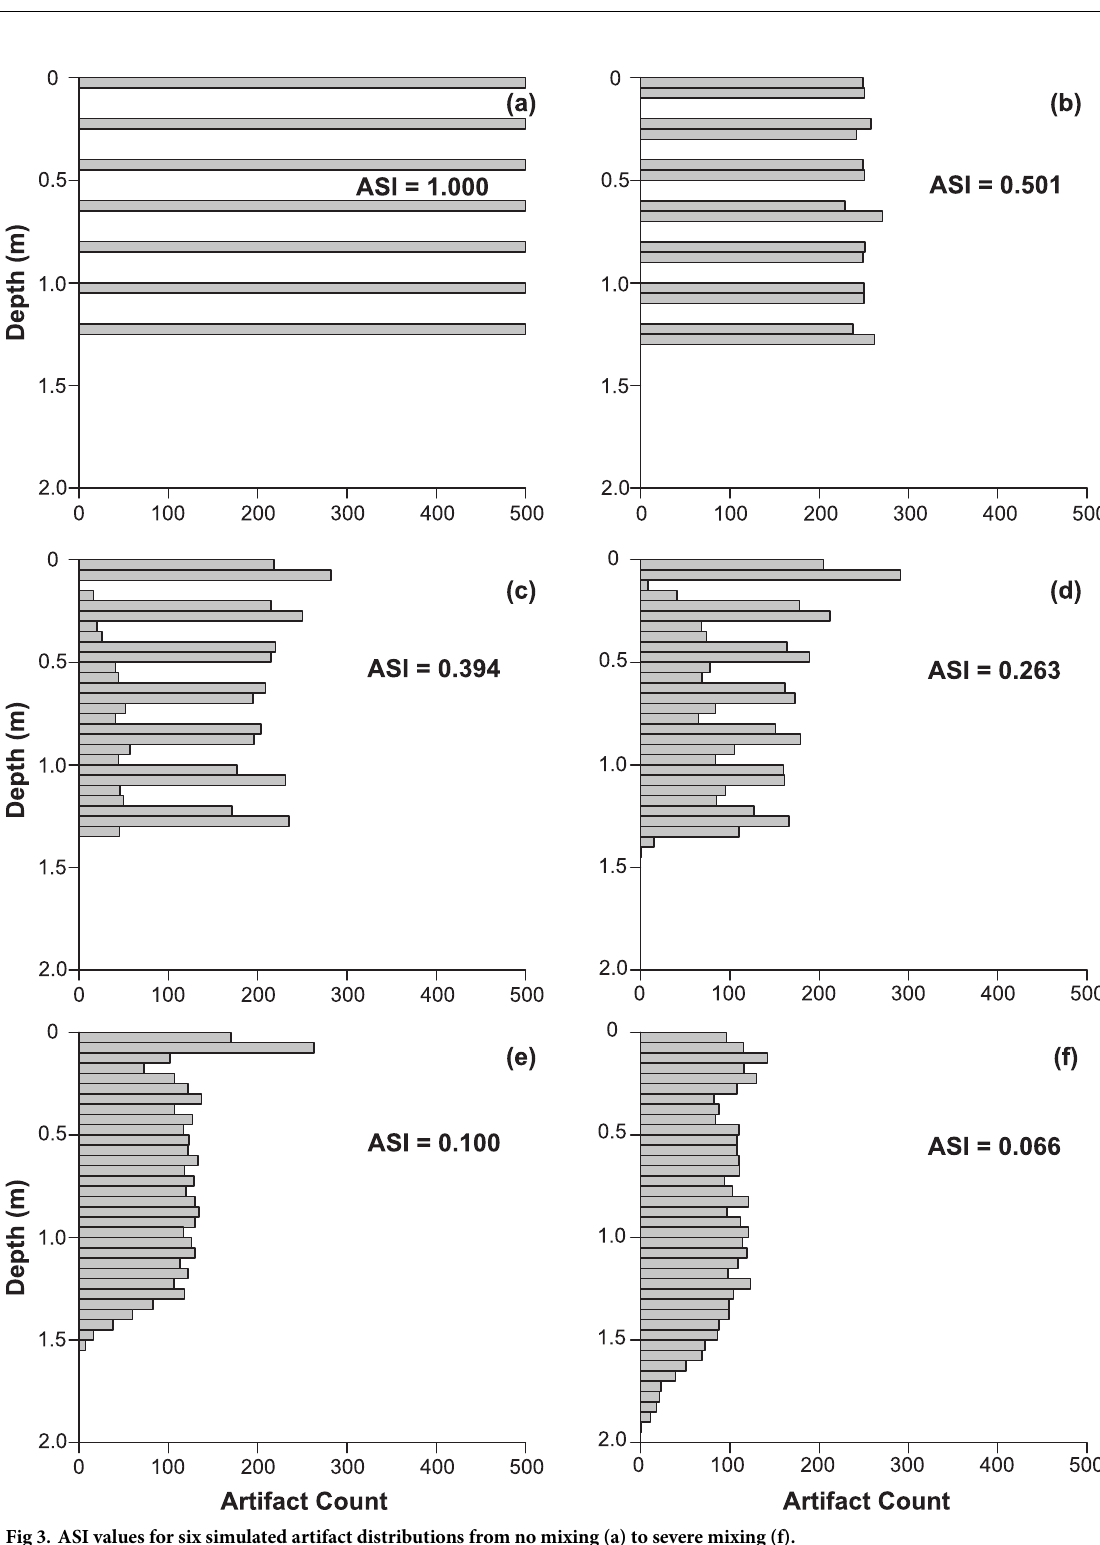
PLOS ONE | https://doi.org/10.1371/journal.pone.0264092 April 20,